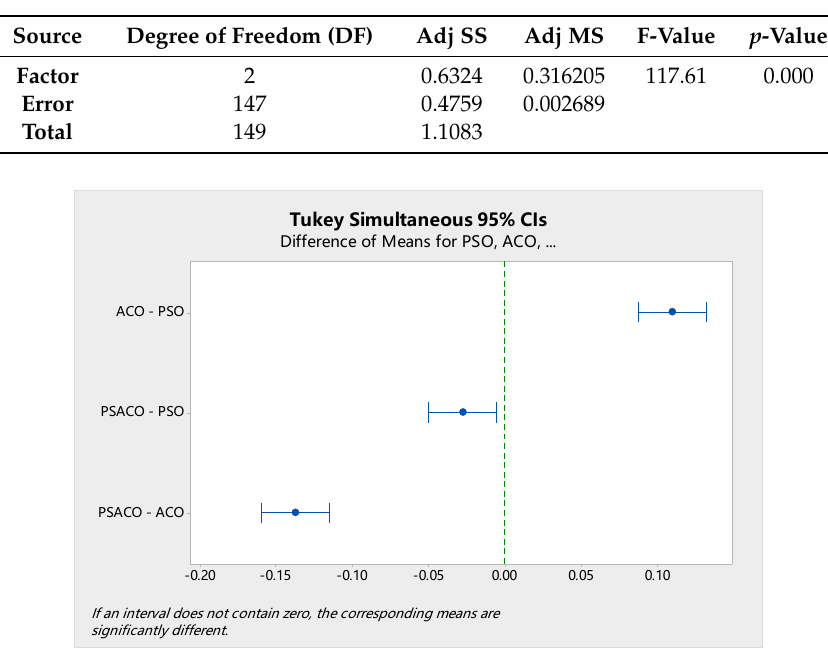
Figure 11. Tukey test at 95% confidence interval (CI).